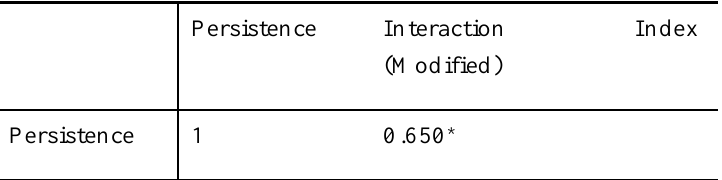
Correlation Coefficient Between the Modified Interaction Frequency Index and